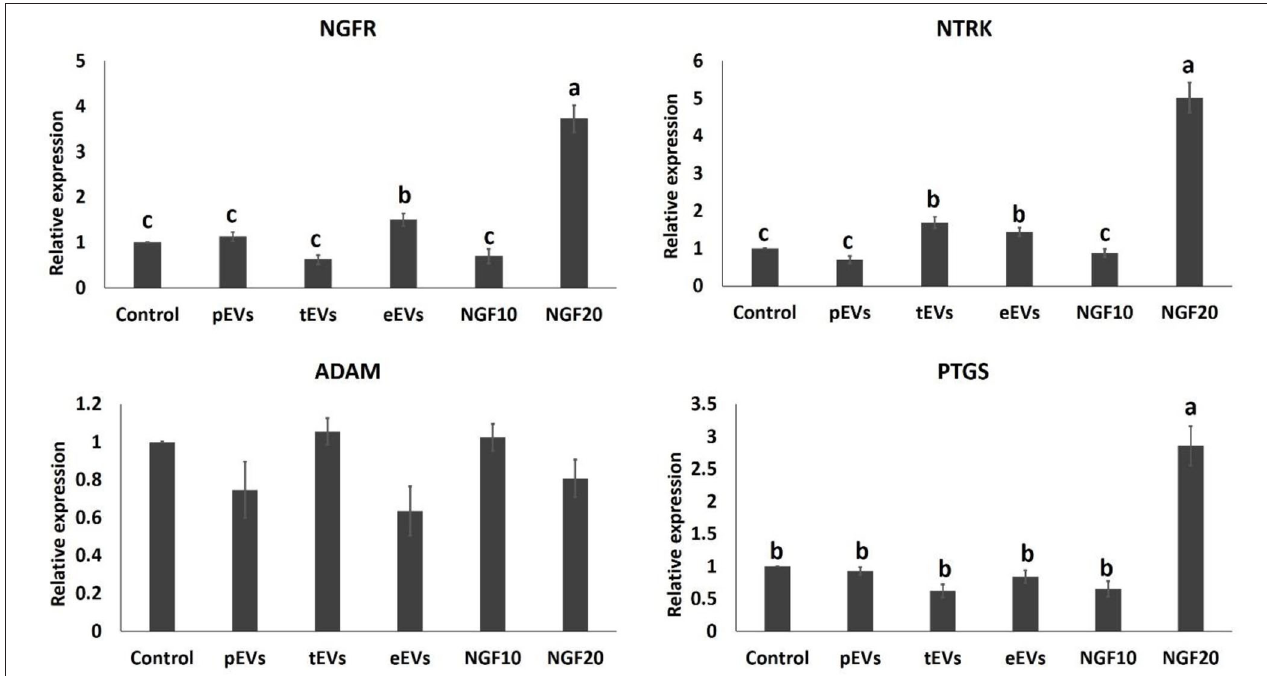
FIGURE 7 | Effects of the prostate, testis, and epididymis extracellular vesicles (EVs) on the gene expression of cumulus cells in comparison to different doses of nerve growth factor (NGF). Different letters ( a – c ) indicate significant difference at p < 0.05.